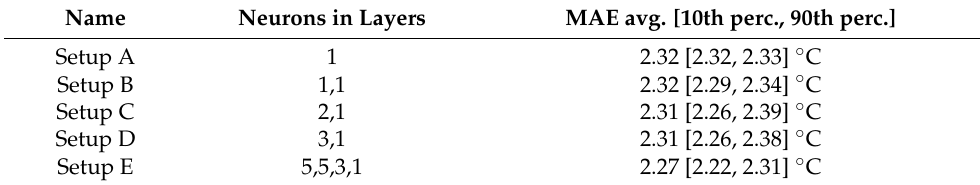
Table 1. Description of the simplistic neural networks consisting of only a few neurons. All setups used the same two input parameters, the average temperature in the lowest layer between the ground and 1 km and the 90th percentile of RH in the layer between the ground and 12 km. The second column denotes the number of neurons in consecutive layers: input layer always contains 2 neurons for 2 input parameters and is not included in the table, whereas the output layer always includes a single neuron. Leaky ReLU was used as activation function for all layers in all setups. The shown MAE values represent the error of the same-day forecast of T max for the testing set. Since 50 realizations of NN training were performed for each setup, the average value, the 10th percentile and the 90th percentile of MAE values are